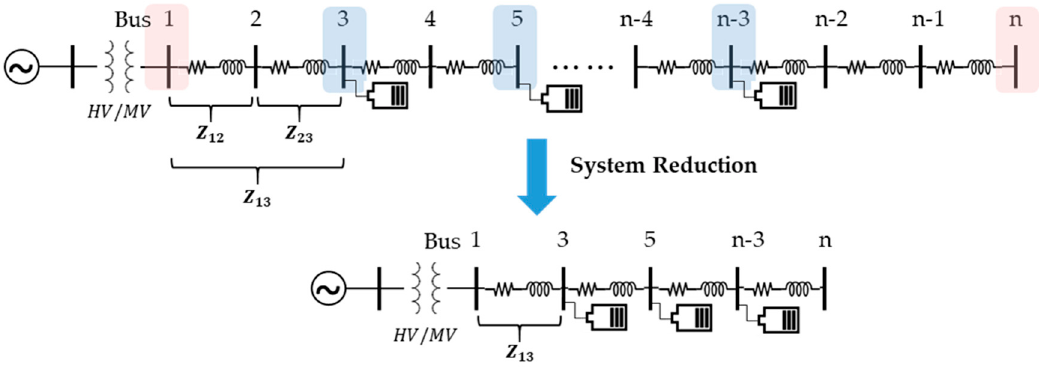
Figure 7. Concept of system reduction method.